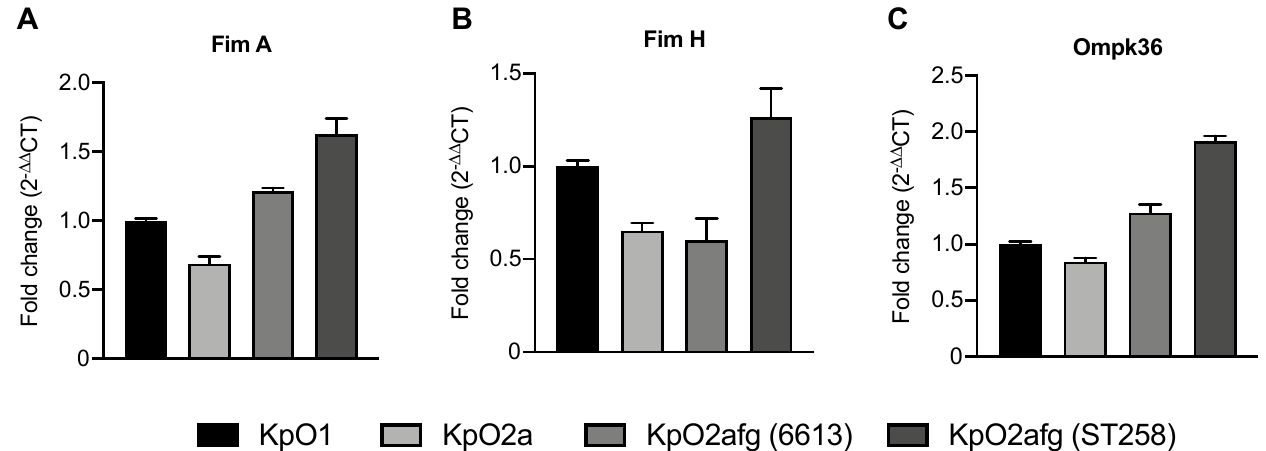
Figure 5. Transcriptional levels of fimA ( A ), fimH ( B ) and ompK36 ( C ). K. pneumoniae mRNA from strains B5055, C5046, 6613 and St258 were quantified by Real-Time PCR. rho was used as a reference gene for the relative quantification and assessed by 2 −ΔΔ CT calculation for each mRNA. Fold changes were calculated based on B5055 transcriptional levels.